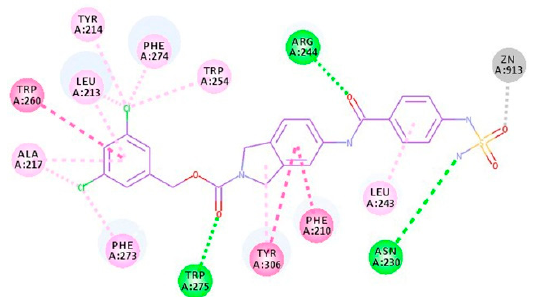
Figure 6. 2D interaction diagram of compound 4 (purple line model). Hydrogen bonds and hydrophobic interactions with the active site residues are displayed as green and pink dashed lines, respectively. Electrostatic interaction with catalytic zinc ion is represented by the gray dashed line.